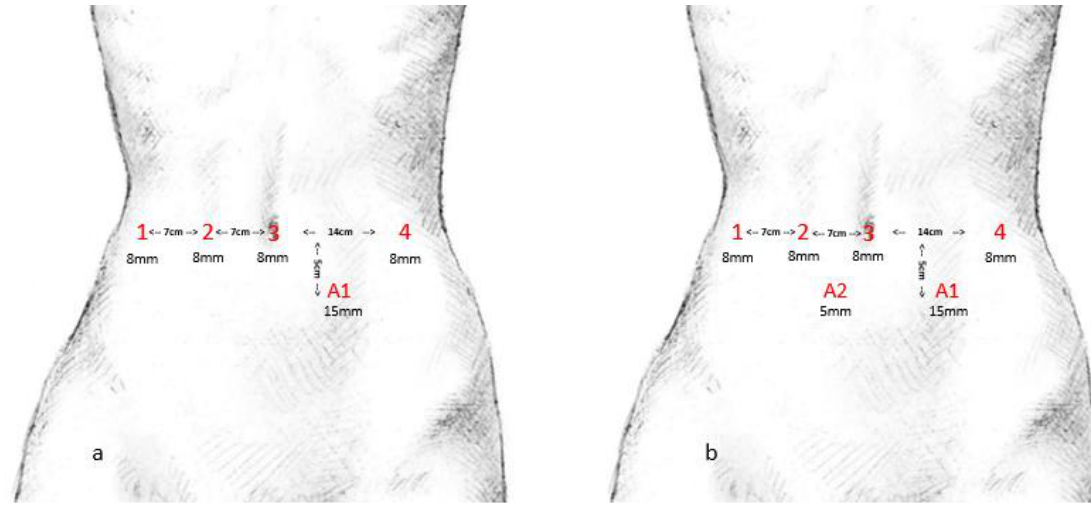
Figure 1. Port placement. ( a ) shows port placement for robotic assisted distal pancreatectomy. ( b ) shows port placement for robotic assisted pancreaticoduodenectomy and total pancreatectomy.